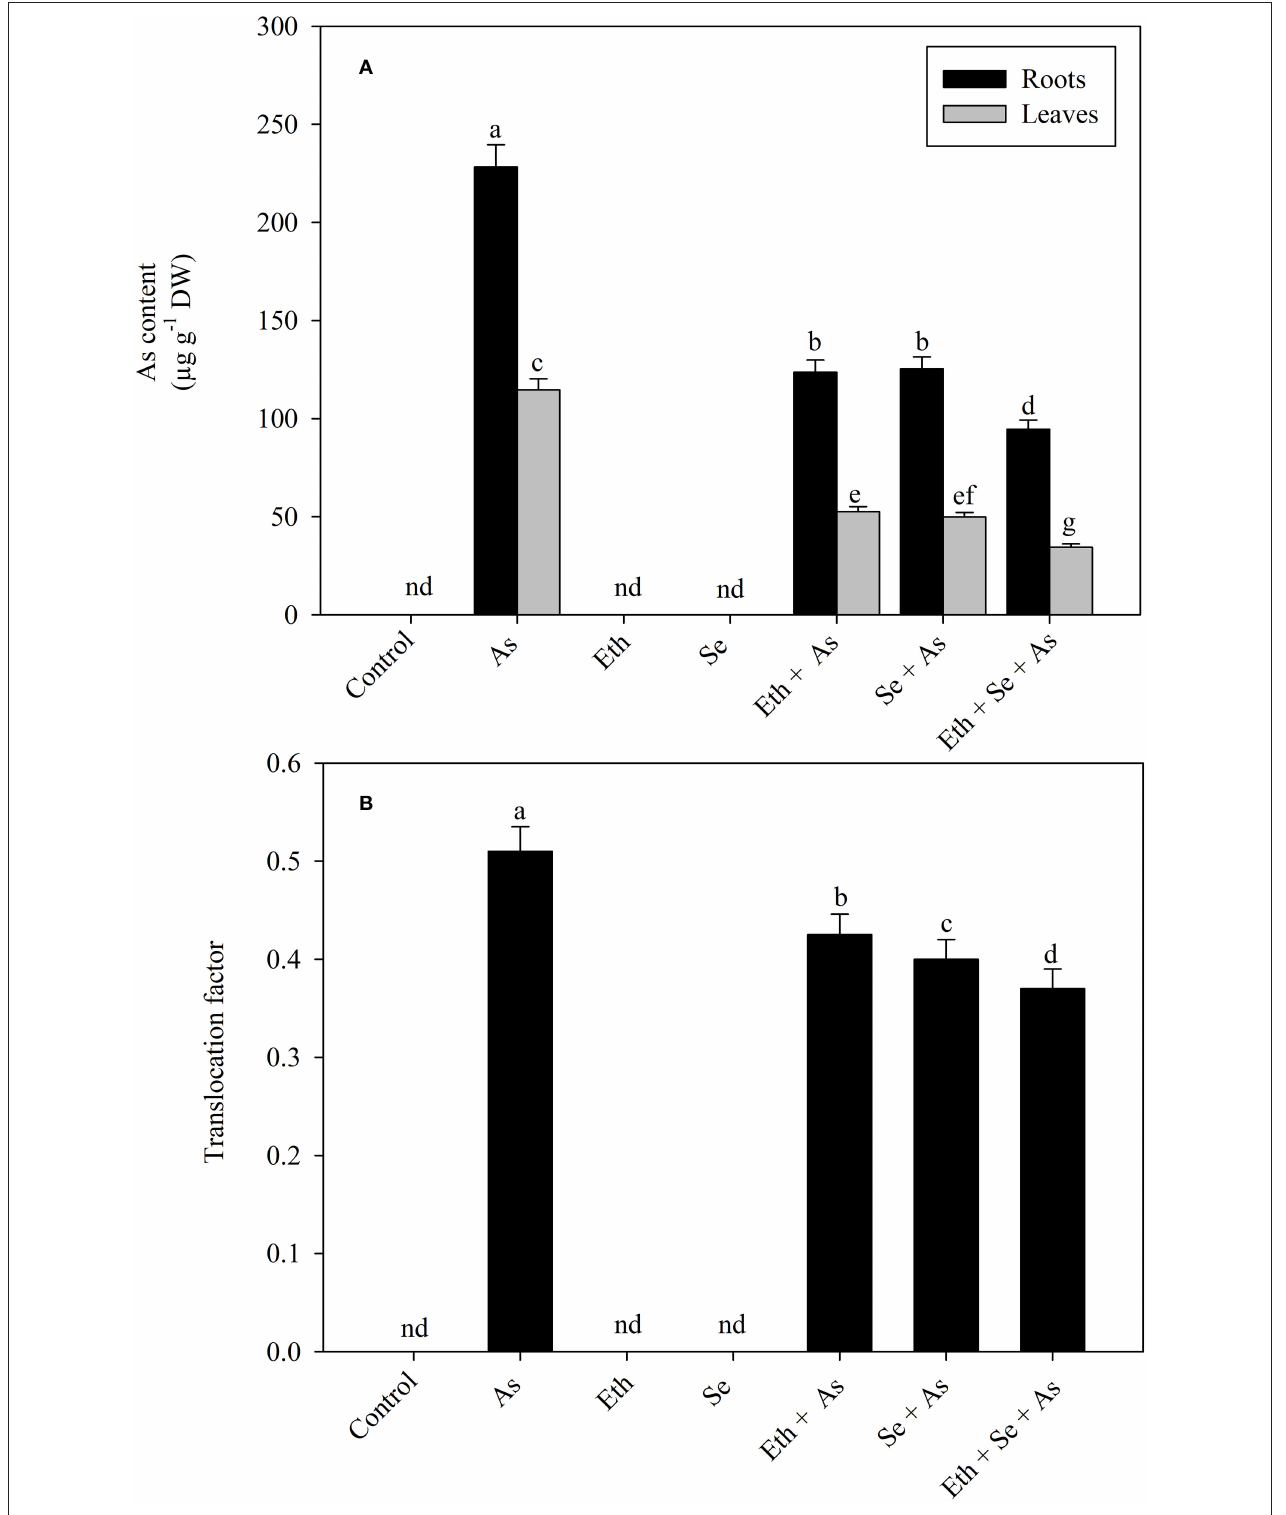
FIGURE 1 | Content of As (A) in roots and leaves and TF (B) of mustard ( B. juncea L.) grown with 200 µ l L − 1 Eth and/or 2-mg Se kg − 1 soil in the presence or absence of 24-mg As kg − 1 soil at 30 DAS. Data are presented as treatment mean ± SE ( n = 4). Data followed by the same letter are not significantly different by LSD test at p < 0.05. As, arsenic; Eth, ethephon; Se, selenium.